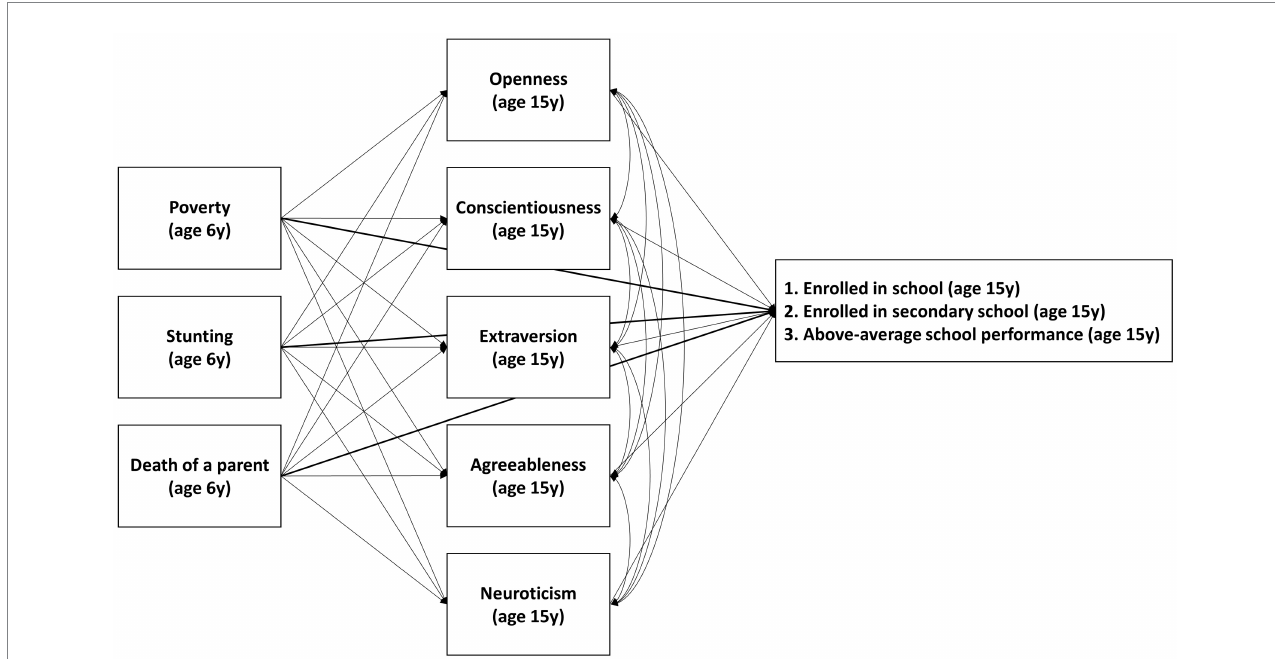
FIGURE 1 Diagram of structural equation models. Notes: Straight lines indicate modeled pathways and curved lines indicate modeled residual